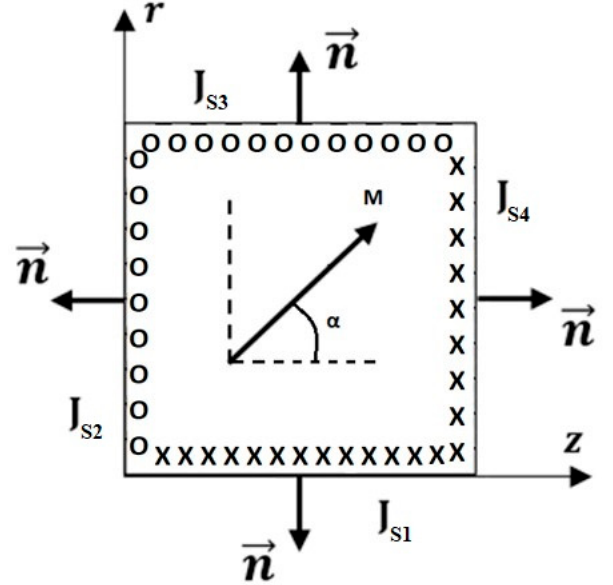
Figure 3. Surface Distributed current model.